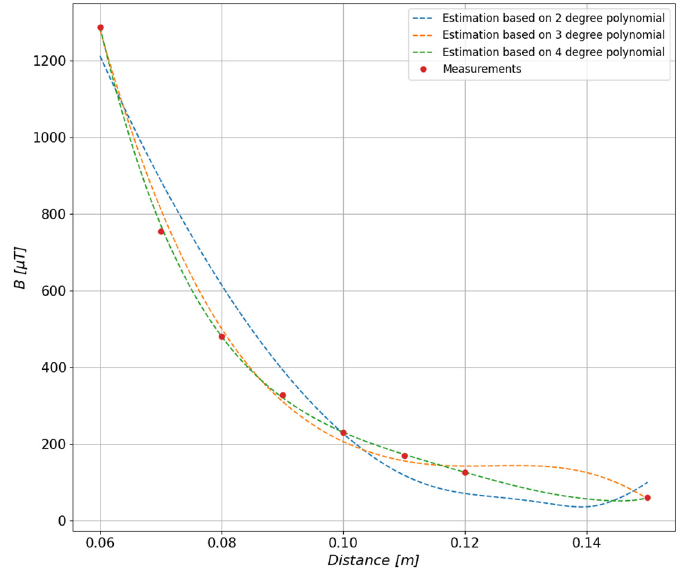
Figure 8. Adjustment of the estimated values depending on the degree of the polynomial deter- mined on the basis of the values measured at the distances of 6 cm, 8 cm, 10 cm, 12 cm, and 15 cm.